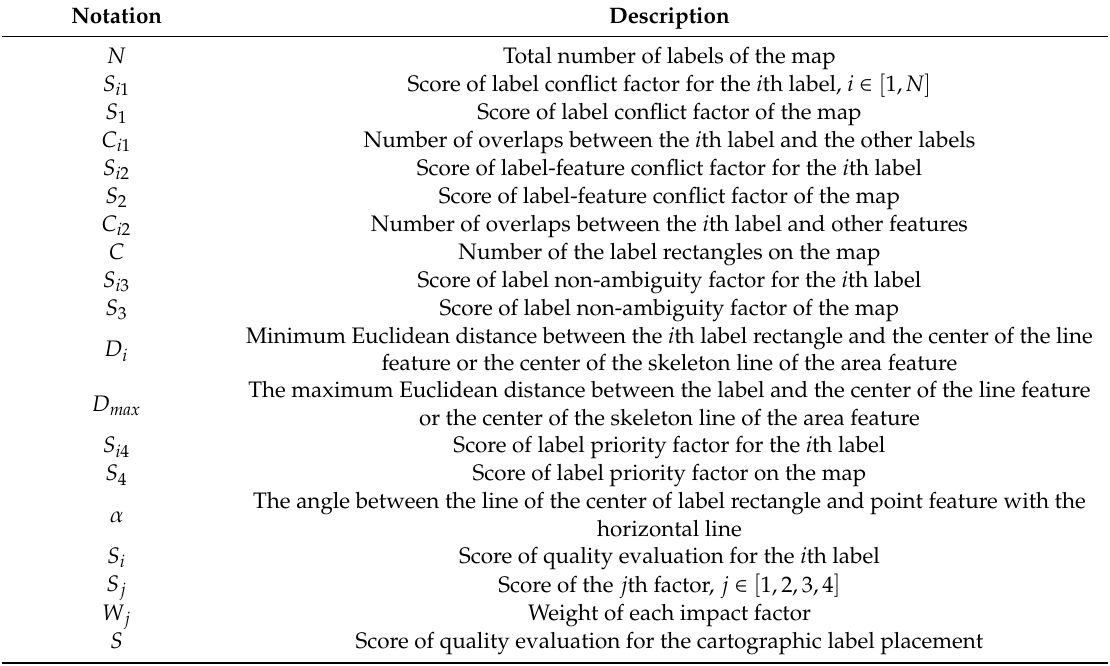
Table 1. Notations and